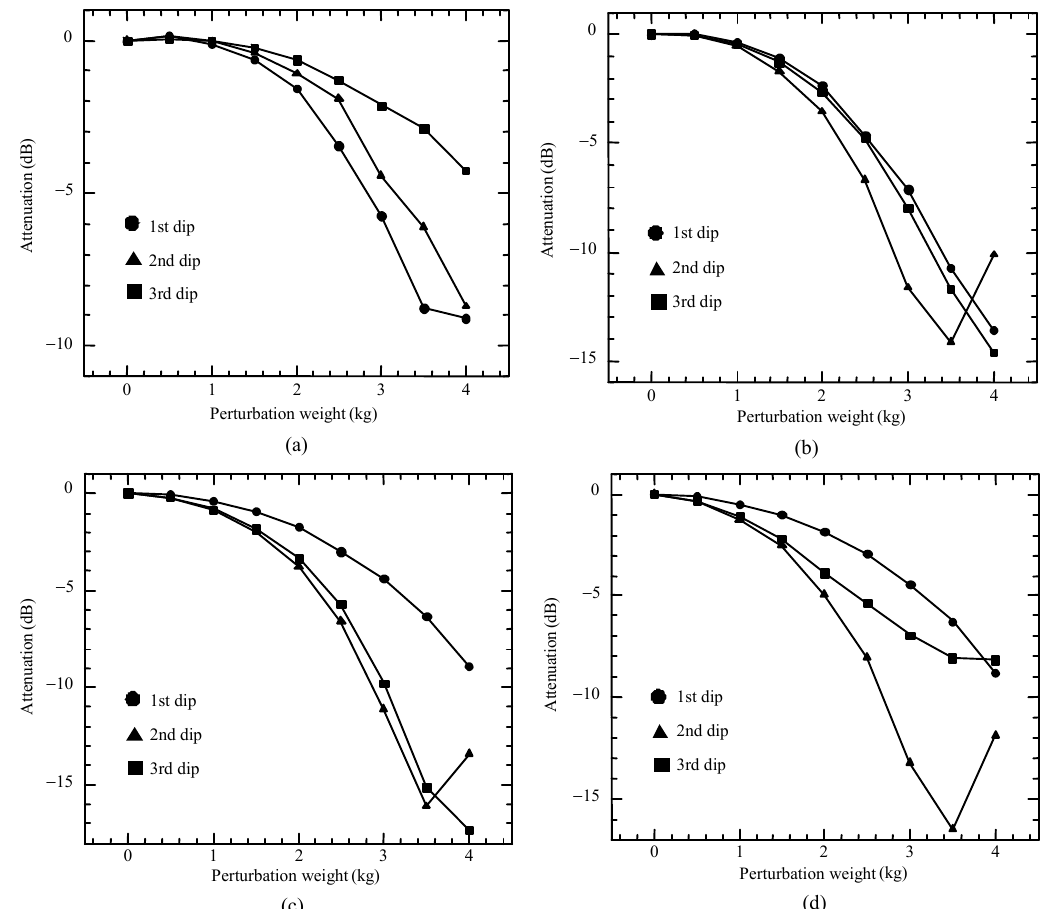
Fig. 6 Relationship between perturbation weights and the attenuation of resonant wavelengths by (a) 520 μ m, (b) 550 μ m, (c) 580 μ m, and (d) 610 μ m grating